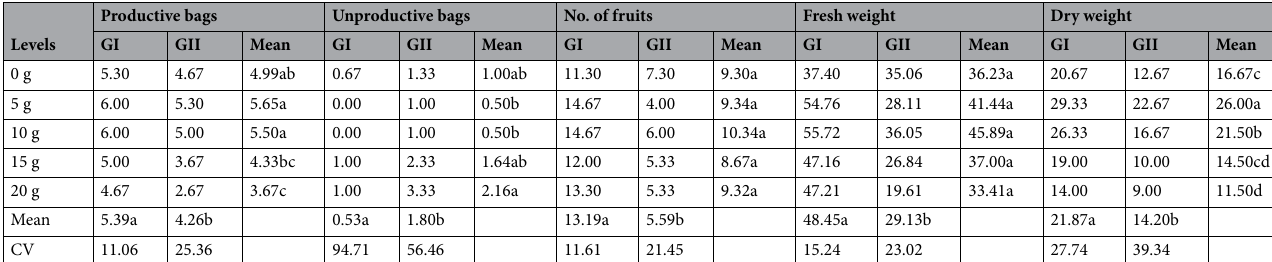
Table 2. Effects of genotypes and limestone levels on yield and yield component traits of the mushroom. Means with the same letter are not significantly different at P = 0.05. LSD 0.05 for comparing two